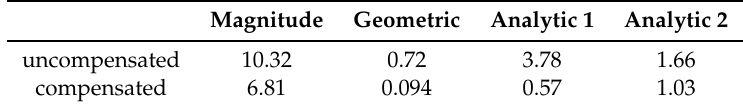
Table 3. The latitude error of biases uncompensated and compensated case (the unit is